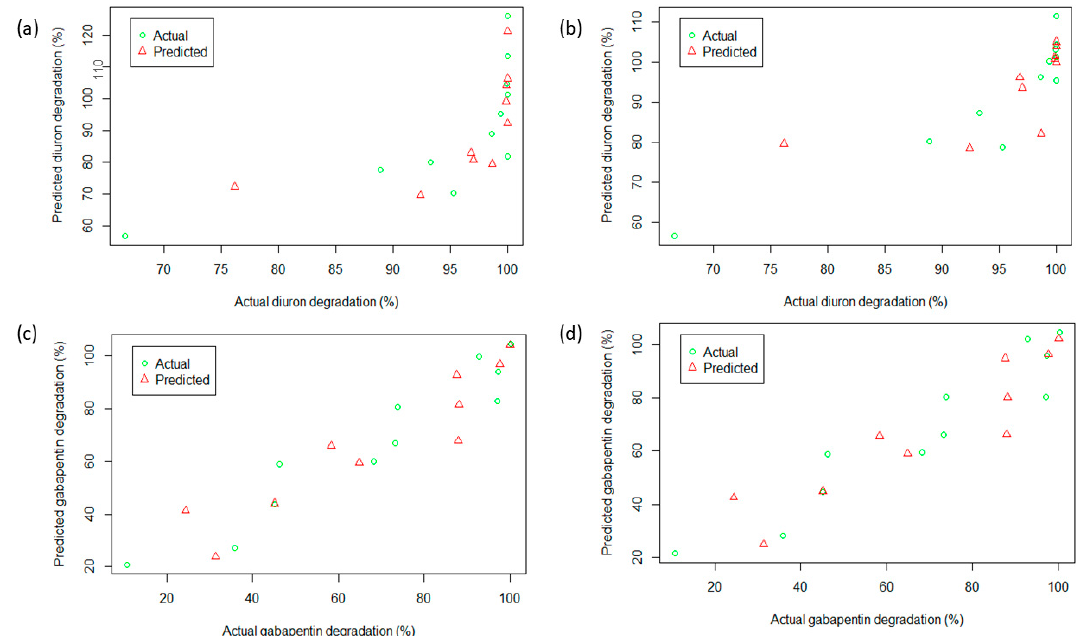
Figure 4. The Gaussian model predicted versus actual degradation ( a ) diuron without process variables interaction, ( b ) diuron with process variables interaction, ( c ) gabapentin without process variables interaction, ( d ) gabapentin with process variables interaction. Table 9. Gaussian model correlation study.